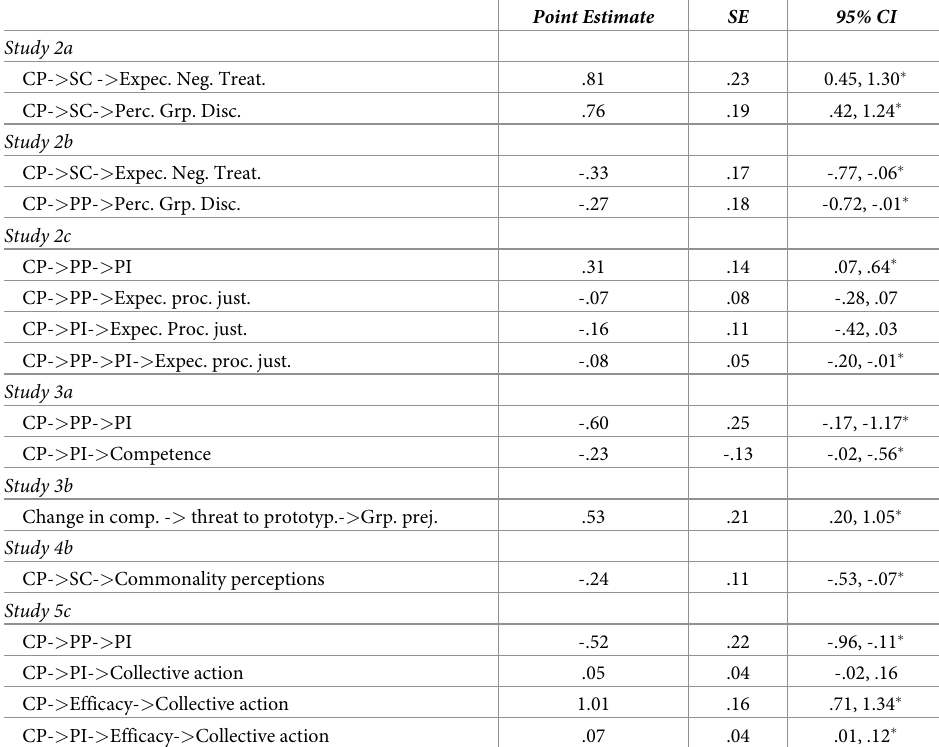
Table 5. Indirect effects for Studies 2a-5c.